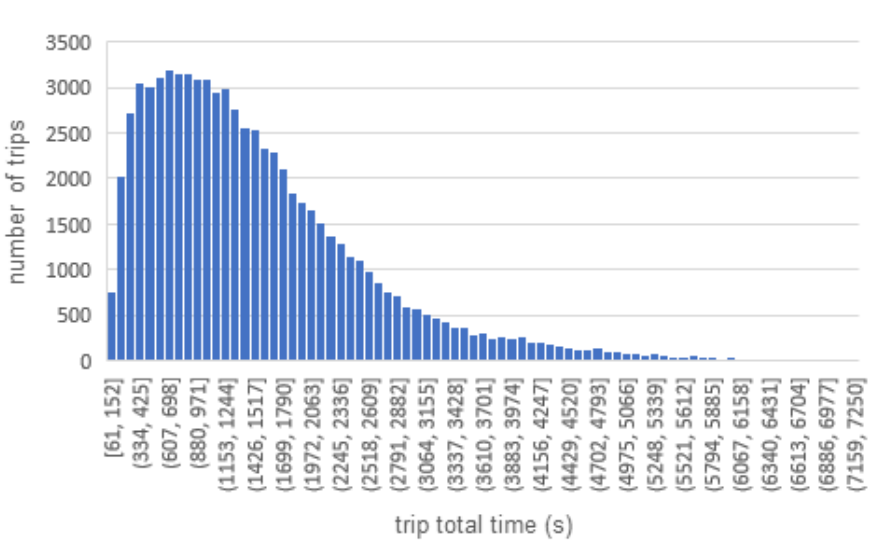
Figure 5. Histogram of trip distance. Data source: BikeCitizens. Image source: the authors.